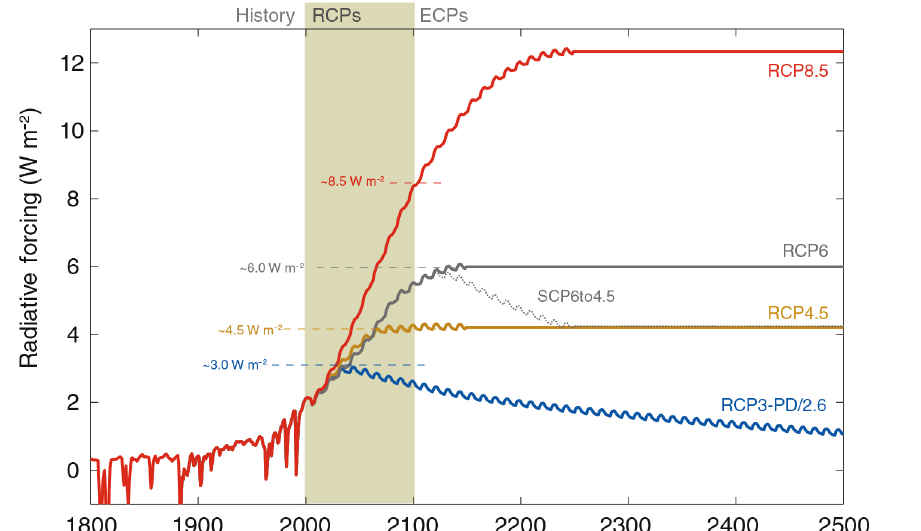
Figure 8. Total radiative forcing (anthropogenic plus natural) for RCPs – supporting the original names of the four pathways, as there is a close match among peaking, stabilization, and 2100 levels for RCP2.6 (also called RCP3-PD), RCP4.5 and RCP6, and RCP8.5, respectively (taken from Meinshausen et al.,